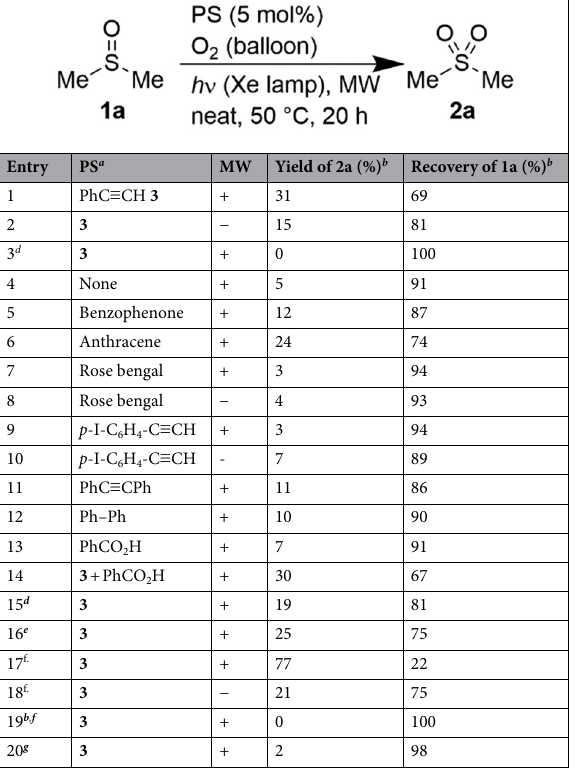
Table 1. Screening of photosensitizer in the MW-assisted photooxidation of dimethyl sulfoxide ( 1a ). Reaction conditions: 1a (15 mmol) and photosensitizer (0.75 mmol) were used with O 2 balloon under MW (8 W) irradiation and white light irradiation from Xe lamp (30 mW/cm 2 at 450 nm) at 50 °C for 20 h. a PS = photosensitizer. b Determined using 1 H NMR with 1,3,5-trimethoxybenzene as the internal standard. c In the dark. d White light (15 mW/cm 2 at 450 nm). e In toluene (1 mL). f 48 h. g In the presence of Co(acac) (0.75